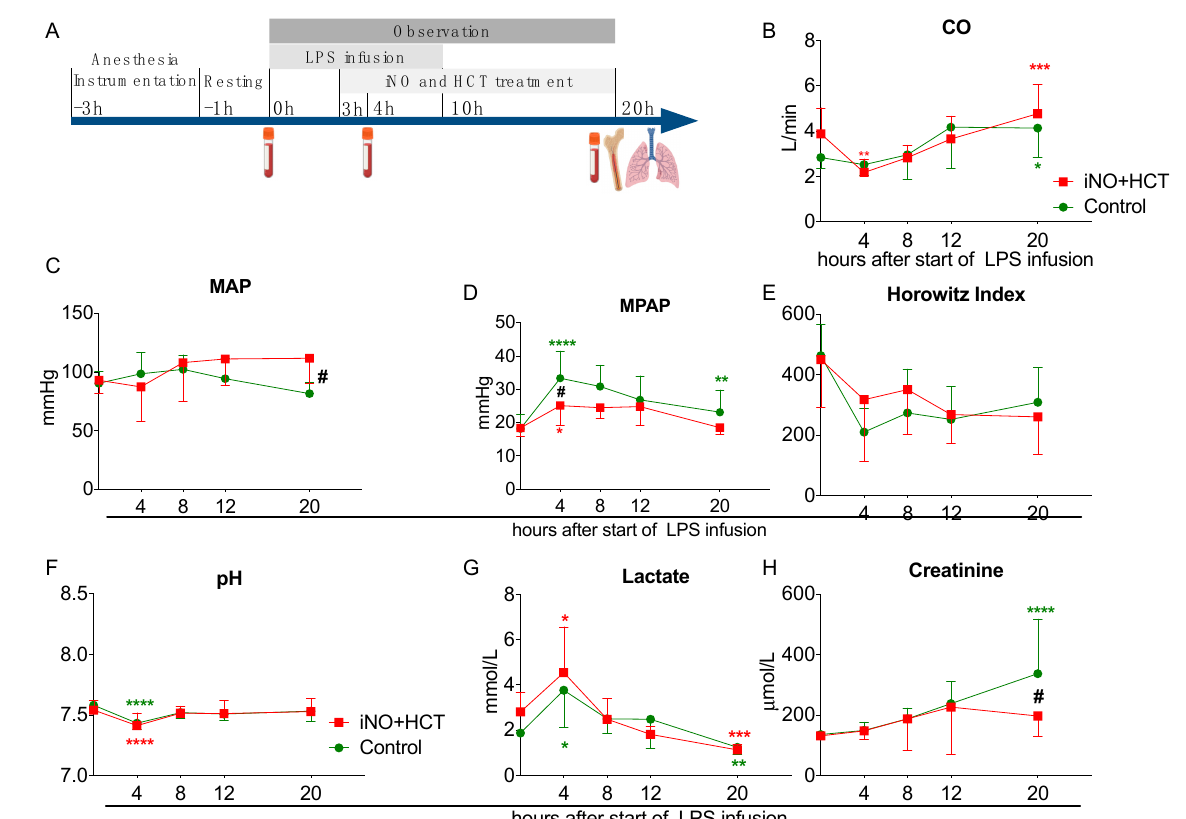
Figure 1. Model of porcine-resuscitated endotoxemic shock and intensive care treatment. ( A ) Schematic presentation of the study protocol. Kinetic changes in the clinical parameters over the course of the endotoxemia model: ( B ) Cardiac output (CO), ( C ) Mean arterial pressure (MAP), ( D ) Mean pulmonary arterial pressure (MPAP), ( E ) Horowitz Index, ( F ) pH, ( G ) Serum lactate concentration, and ( H ) Serum creatinine levels. Mean values ± SD are presented. Baseline, T4 h T8 h n = 9/group, T20 h n = 6/group. The statistical significance of differences between values at baseline and given timepoints for each group: * p < 0.05, ** p < 0.01, *** p < 0.001, **** p < 0.0001. The statistical significance of the differences between groups at given timepoints: # p < 0.05. LPS lipopolysaccharide, HCT